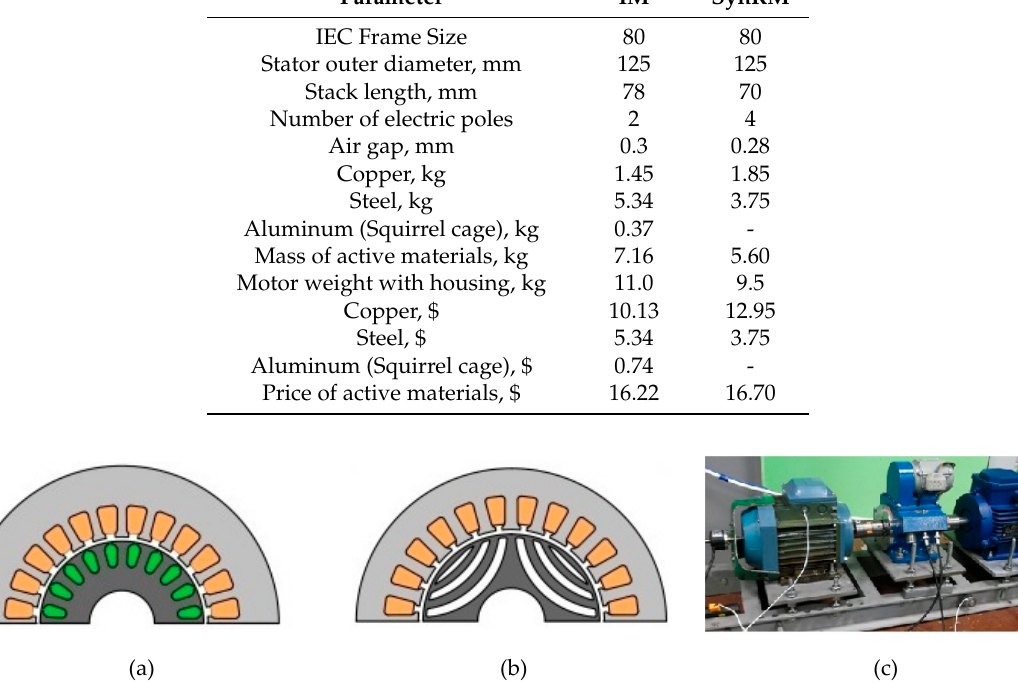
Figure 3. ( a ) Sketch of IM geometry; ( b ) Sketch of SynRM geometry; ( c ) The experimental test